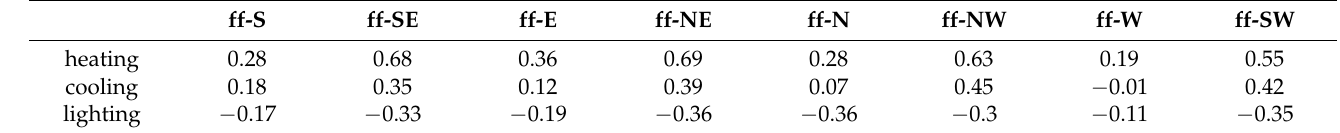
Table 7. Correlation coefficients between energy demands and ff-orientations for the